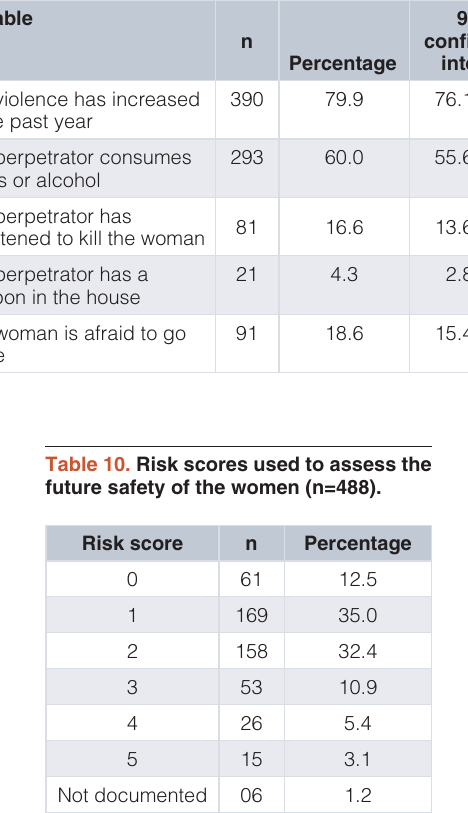
Table 11. Services provided at each visit to a gender-based violence care centers (n=488).